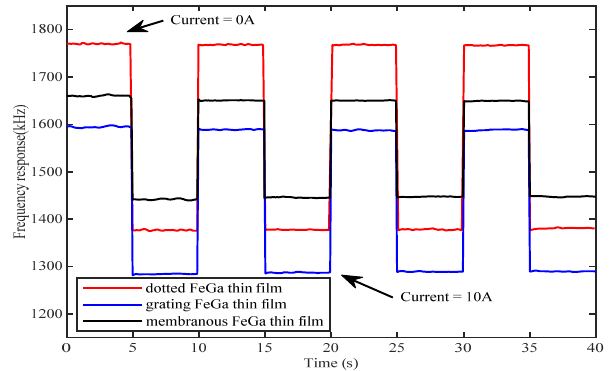
Figure 8. The repeatability of the proposed sensors.